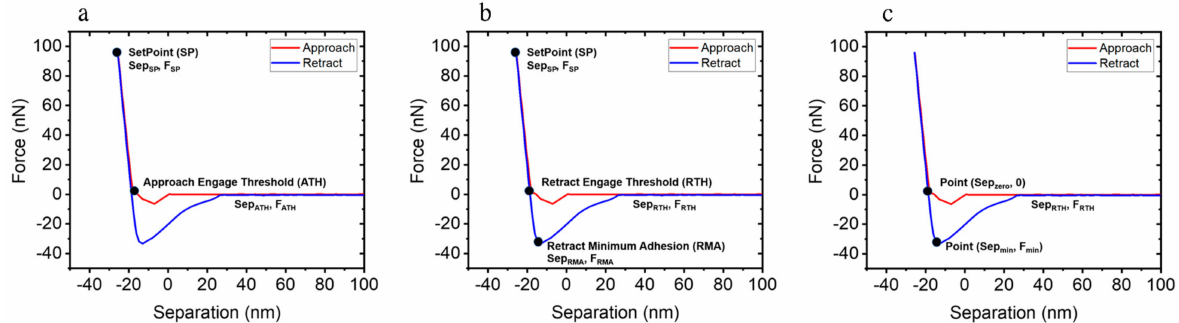
Figure 1. Experimental force–separation curves based on ( a ) the Hertzian model, ( b ) the DMT model, and ( c ) the JKR